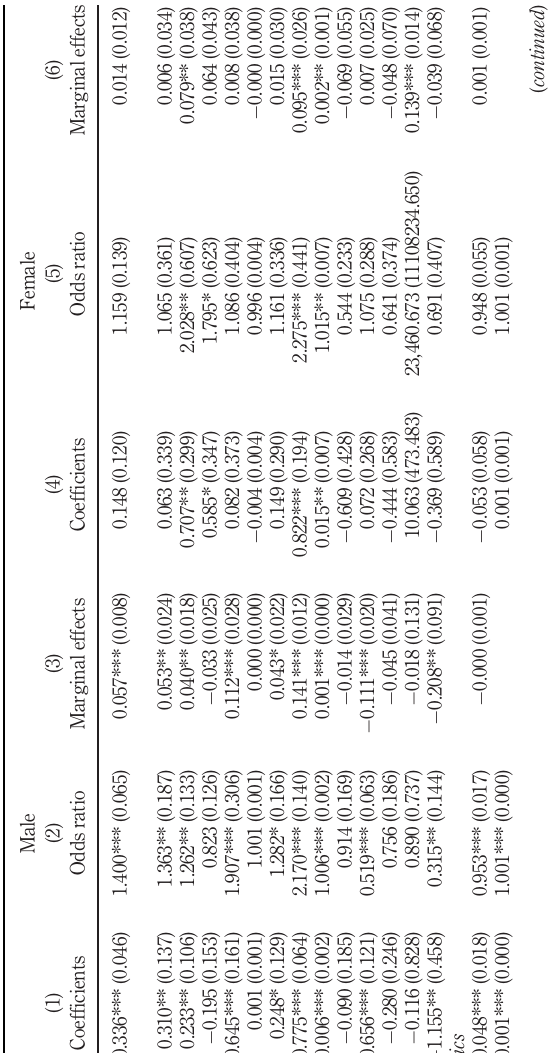
Table AVIII. Ordered logit estimation results for determinants of job satisfaction by